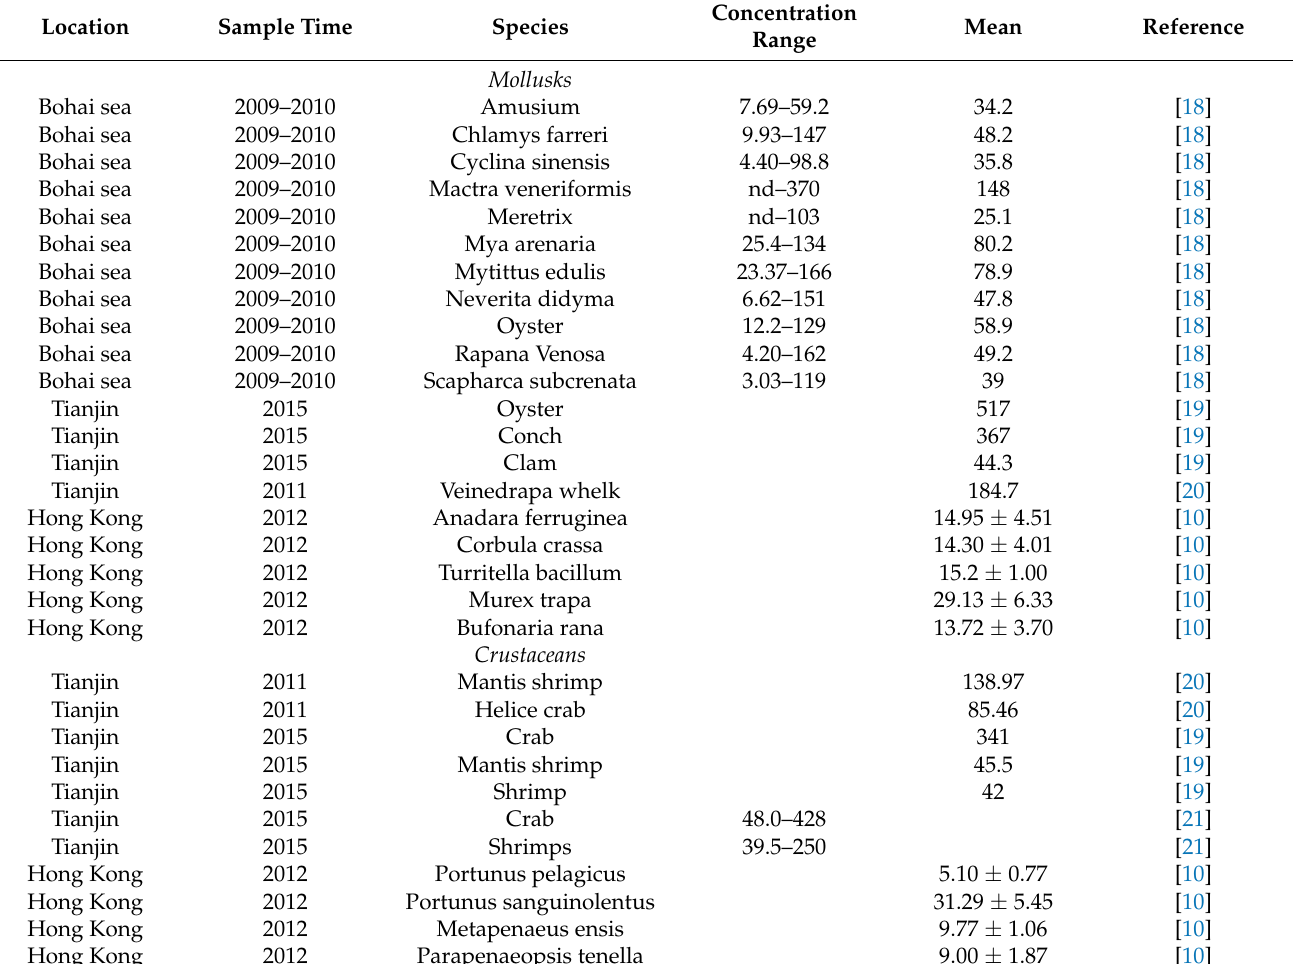
Table 1. Concentrations of HBCDs in marine organisms from China (ng/g lipid